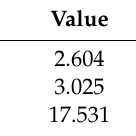
Table 2. Cluster separability.